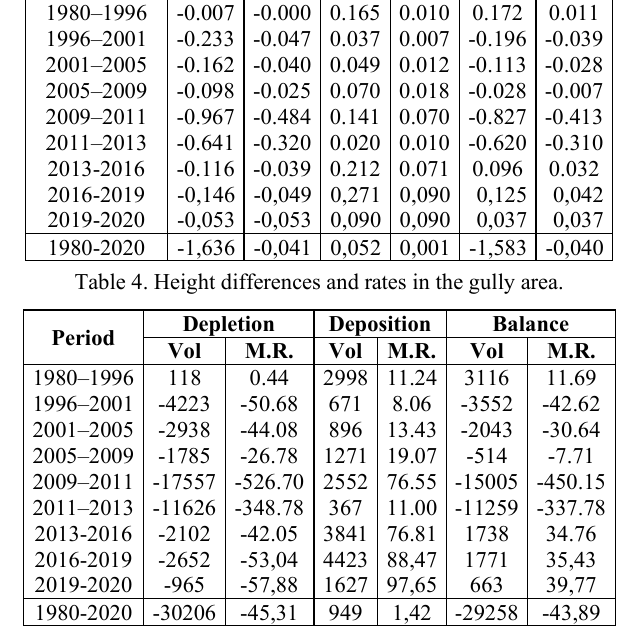
Table 5. Volumes in the gully area. Volumes are m 3 . Mass rates (M.R.) are in t/ha*year. Table 6, it can be observed that the mean annual rainfall was 470 mm with a standard deviation of 158, ranging from 230 and 903 mm. In general a slightly increase (over 10%) of the main rainfalls were observed from values under 500 mm in the first 5-years periods to values over 500 mm in the last periods (except for the very last). The maximum values accumulated in 1 day (24 h), 7 days (a week), 1 month and 3 months also showed some increase in the last 5-years periods regarding the first ones. This was near 30% in 1-day rainfalls and between 5- 10% in the other accumulated rainfalls. Regarding monthly rainfalls, the average was of 39.8 mm with a high Std of 41.5, ranging from 3.2 mm in July to 65.3 mm in December.